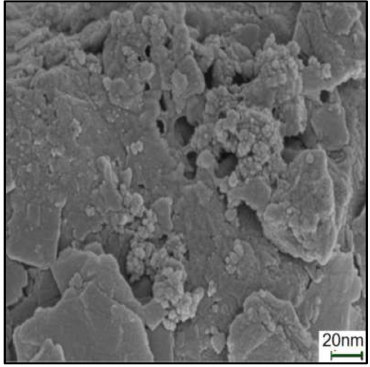
Figure 3. SEM image of coral